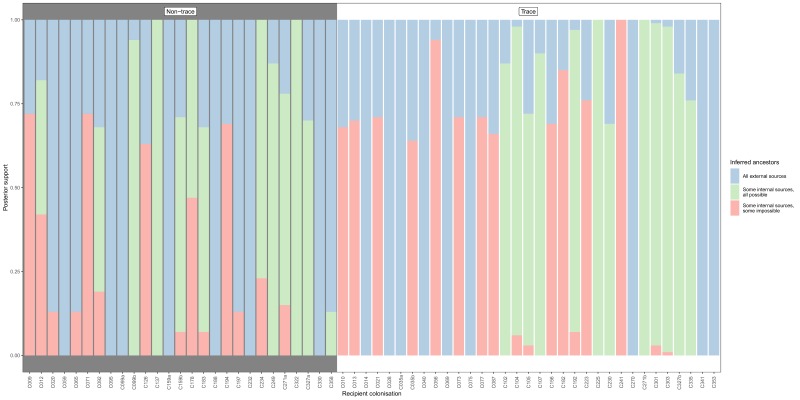
Concordance of inferred infectors for each colonisation with recorded timings of hospital stays and sampling dates, from a secondary phyloscanner analysis in which the tip set from each subject was randomly downsampled until a maximum of five remained.Each bar represents a colonisation, and the colours represent the proportions of the posterior set of trees where the transmission chain prior to that host involves no sampled subjects (blue), involves one or more sampled subjects all of which are possible given known timings of entry and departure to the hospital and sampling of isolates (green) and at least one sampled subject where the timings are in conflict, with the infector entering the hospital after isolates from the recipient were acquired (red). The graph is divided into non-trace (left) and trace (right) colonisations.